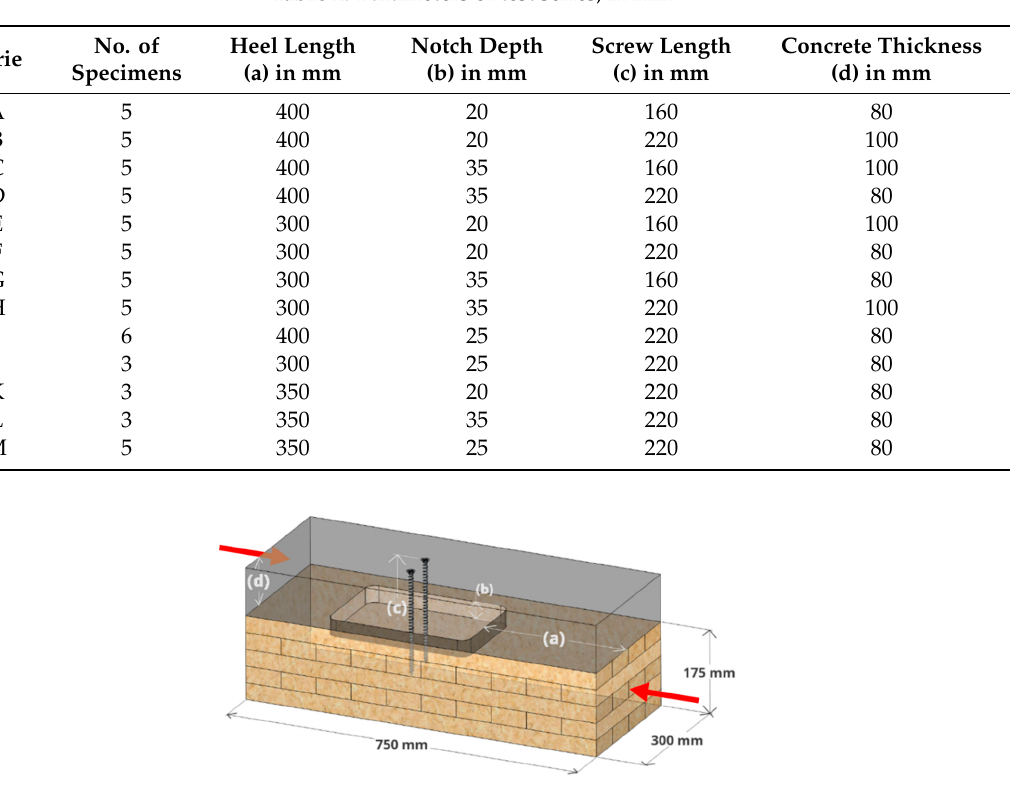
Table 2. Parameters of test series, in mm.